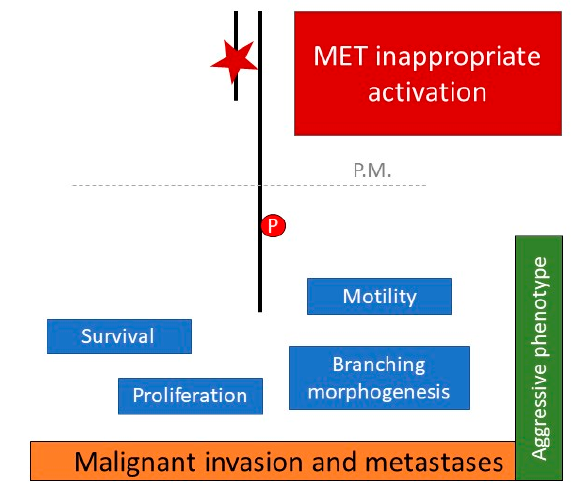
Figure 2. The MET-driven invasive growth. Biological features of the invasive growth program orchestrated by the MET oncogene. In the case of brain metastases from lung cancer, MET activation is related to the occurrence of somatic mutations ( ) affecting the receptor’s extracellular SEMA domain.